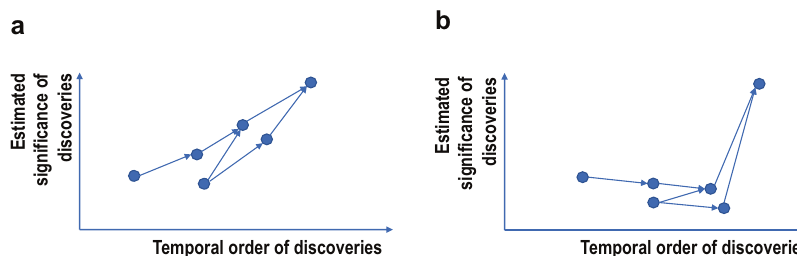
Fig. 6 The landscape of estimated signi fi cance of the discovery. a The landscape is monotonic, and b the landscape is non-monotonic. A simpli fi ed illustration on why there are cases that research outcomes not immediately recognized to be signi fi cant lead to a major discovery. “ Estimated signi fi cance of discoveries ” is used only as a conceptual index. There is no rigid method to estimate the signi fi cance of the discovery. The numbers of citations and their temporal changes can be an interesting index, but it may be biased toward short-term popularity unless the time horizon is set appropriately.